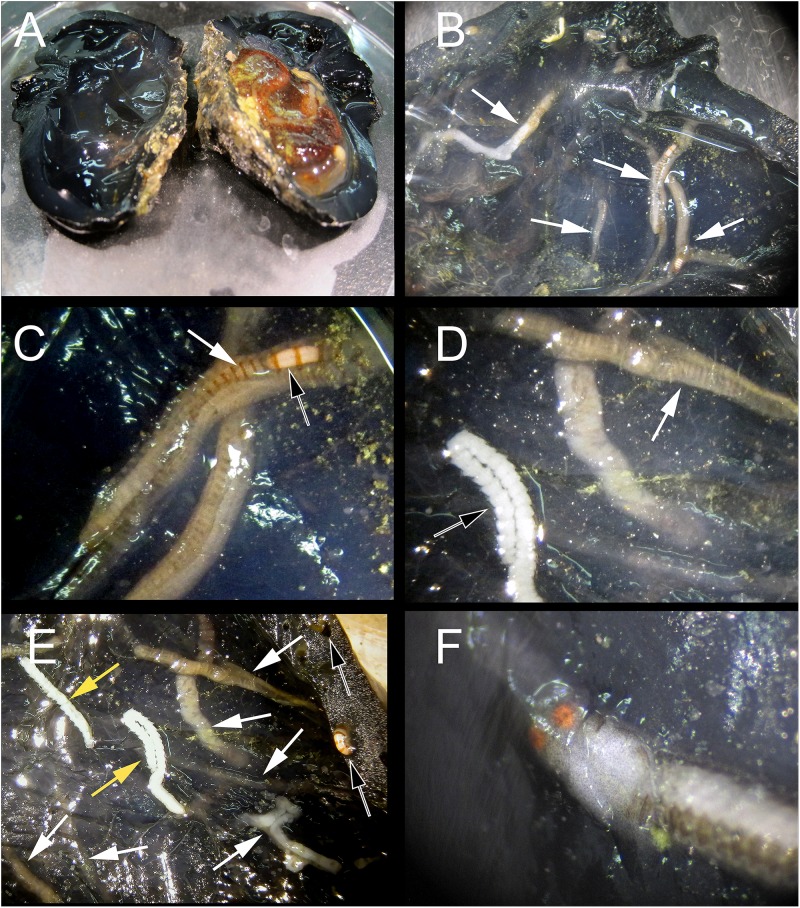
Host dissection and location of mining polychaetes.(A) An uninfected Phallusia nigra dissected to show normal atrial surface (left) and internal organs. (B) Inner atrial surface showing the presence of several atokous forms inside their galleries (white arrows). (C) Detail of the color of the anterior region of an atokous form; white arrow: position of pharynx; black arrow: position of proventricle. (D) Detail of color of the mid-body of an atokous form (white arrow) and the posterior region of a male epitokous form (black arrow). (E) Inner atrial surface showing the presence of atokous (white arrows) and male epitokous (yellow arrows) forms inside their galleries, as well as part of the banded body of an atokous form protruding from an external tunic opening and other empty tunic openings (black arrows). (F) Close-up view of the head of a male epitoke in its gallery (specimen not preserved).